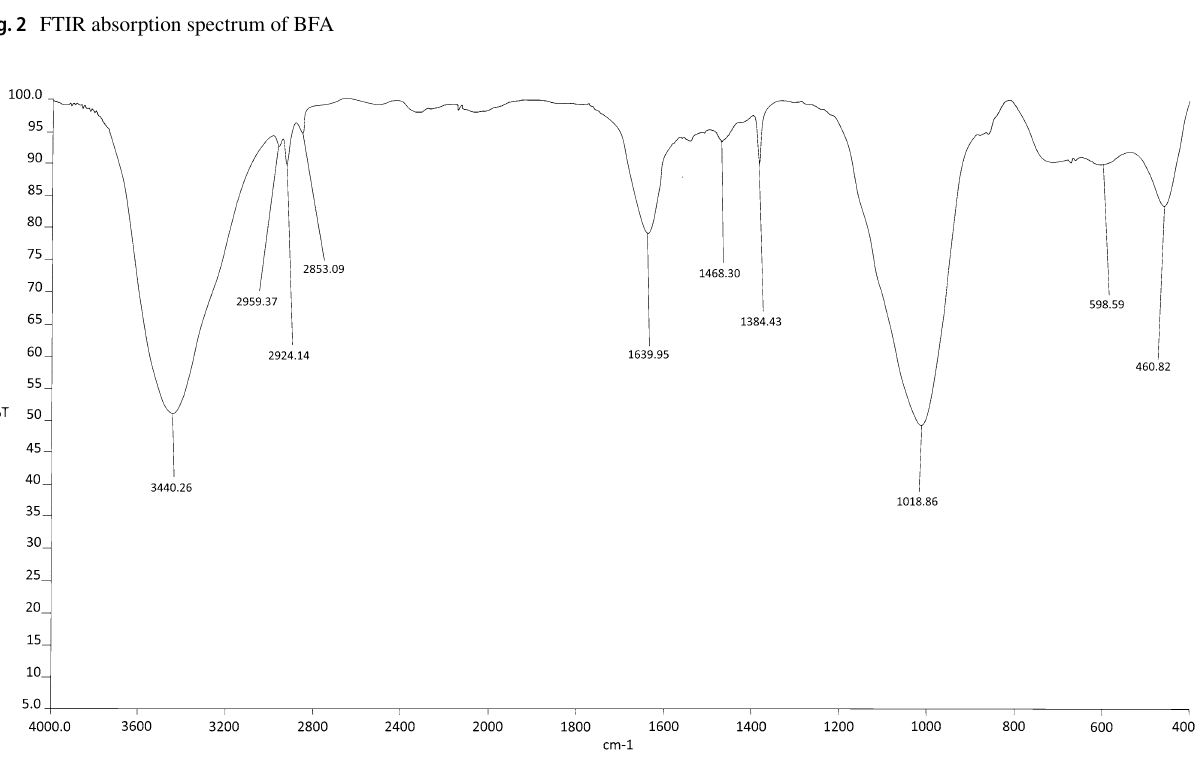
Fig. 3 FTIR absorption spectrum of